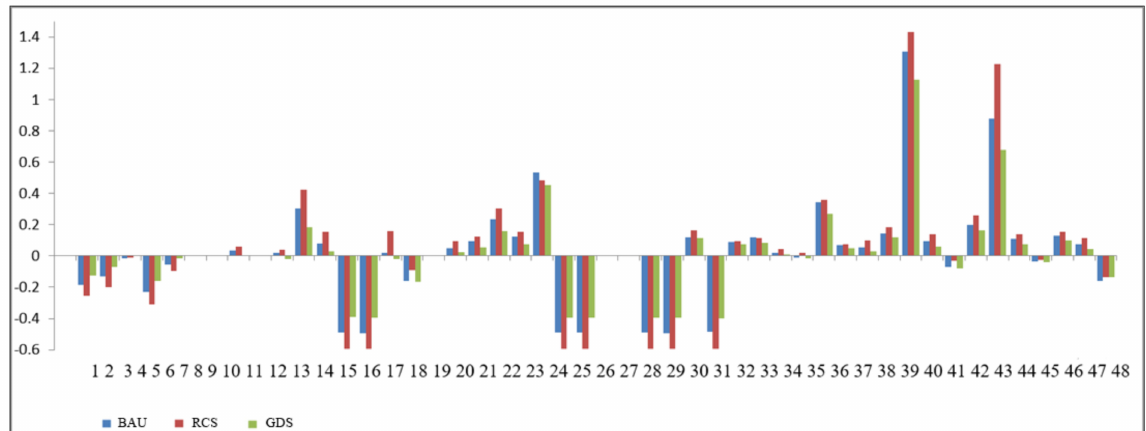
Figure 6. Change of land demand of each industrial sector in different scenarios. (Note: the mapping relationship between code and sectors is listed in Appendix